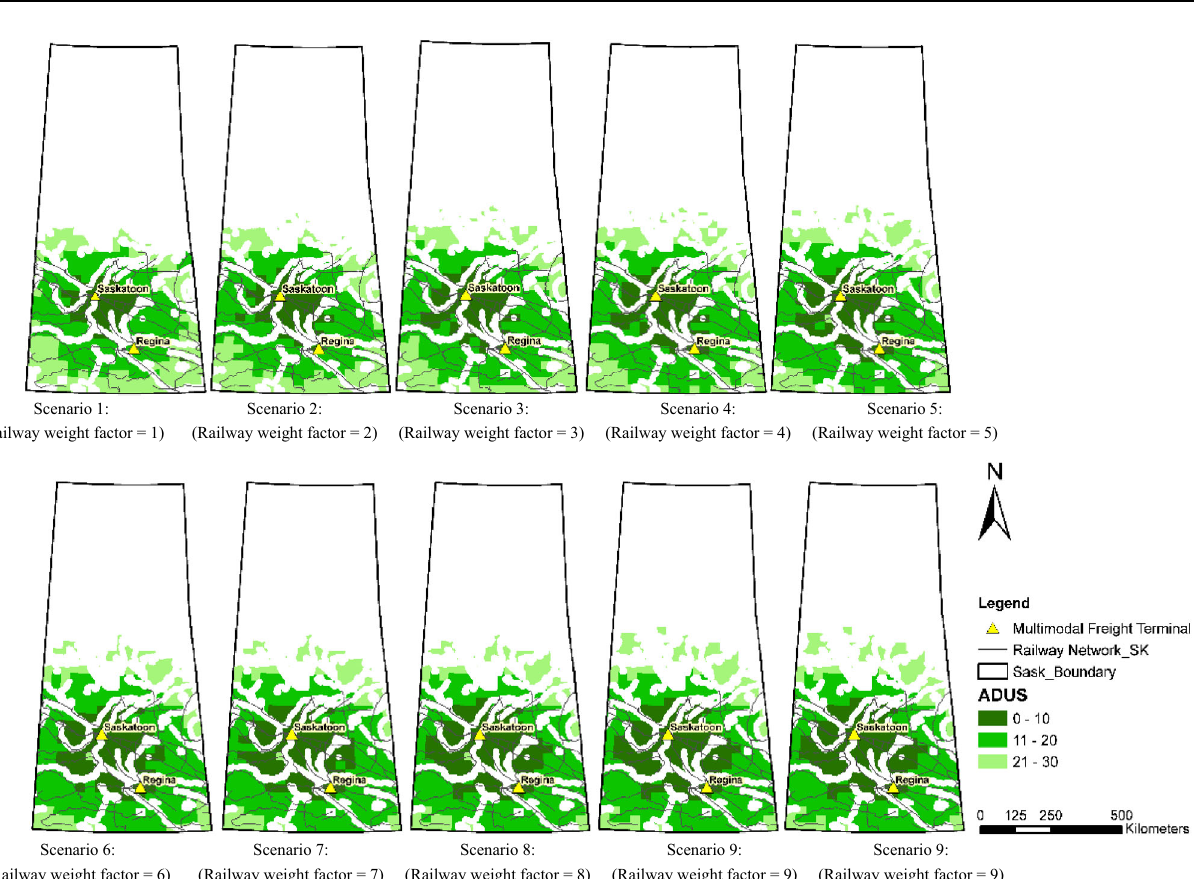
Fig. 15 Quantity and spatial distribution of the most suitable, suitable, and less suitable zones considering different railway weight factors